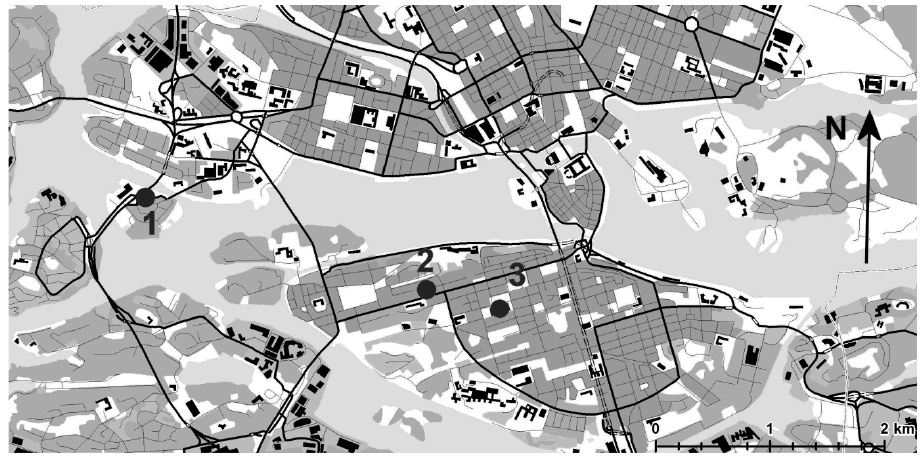
Fig. 2. Location of the monitoring stations in Stockholm: Essingeleden (1), Hornsgatan (2), and Torkel (3). Blue indicates water surfaces, green forest/park areas, orange built-up areas, black lines important roads, and grey represent public buildings (e.g., hospitals, museums,